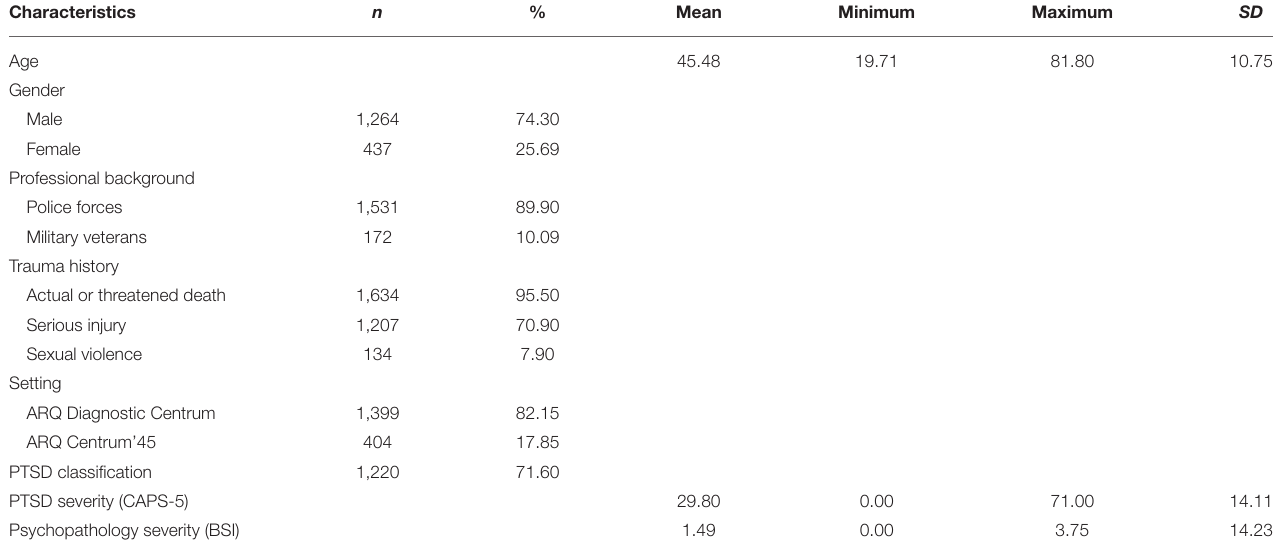
TABLE 1 | Demographic and clinical characteristics ( n = 1,703).